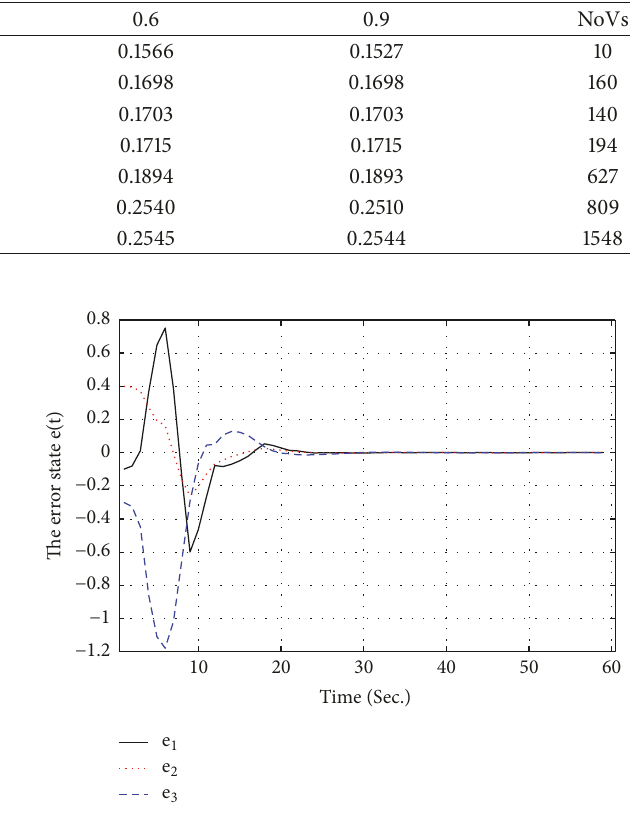
Table 2: MADUBs ℎ for different 𝜇 (Example 2).